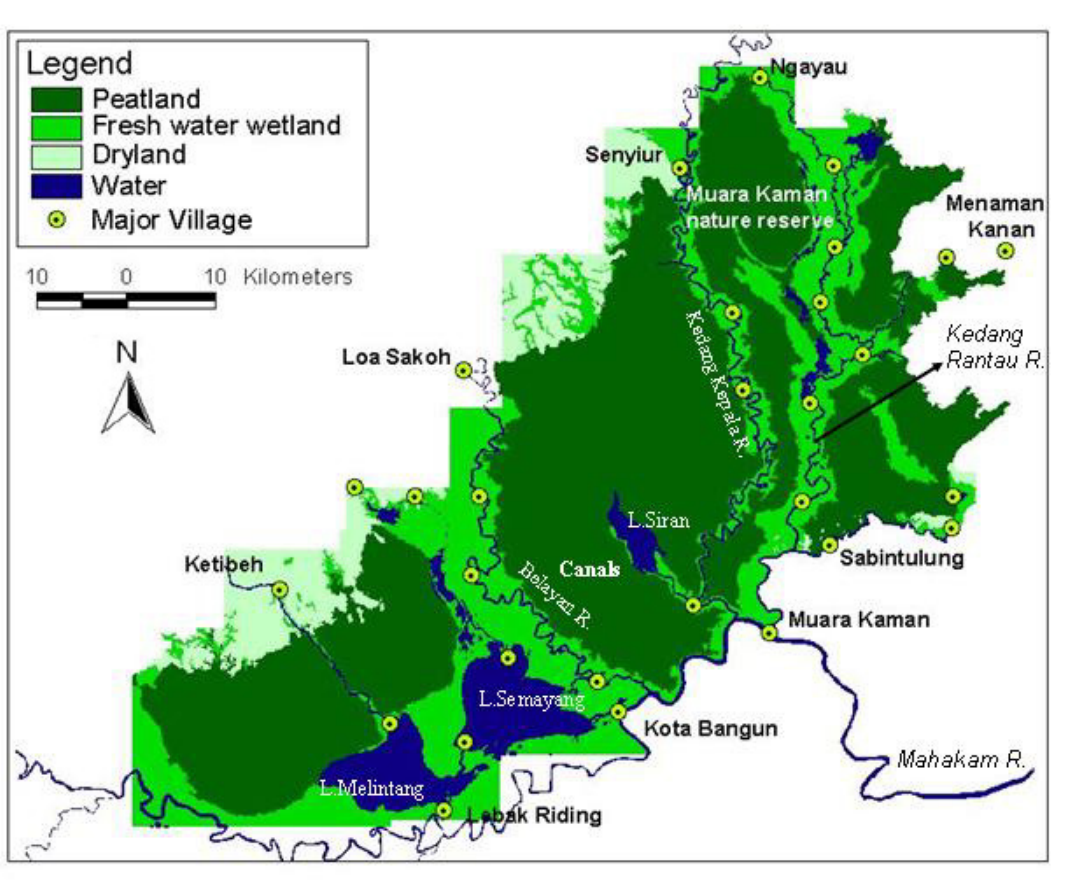
Fig. 2. Key features of the Middle Mahakam study